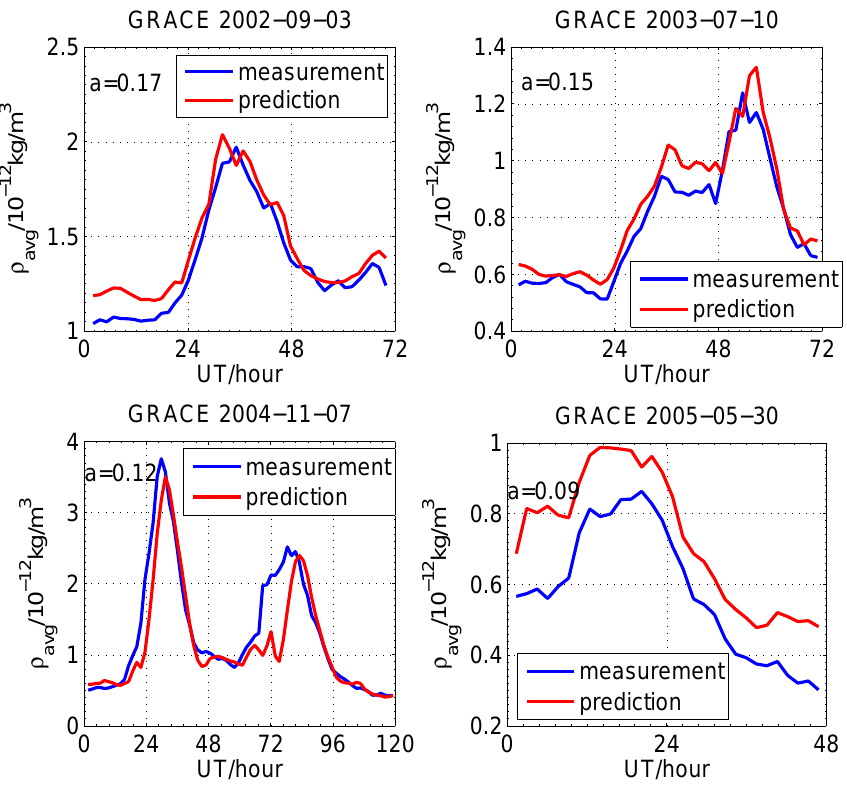
Fig. 6. The same format as Fig. 5, but for the GRACE density data. Different a values are used for different storms. The a value is shown in the top left corner of each